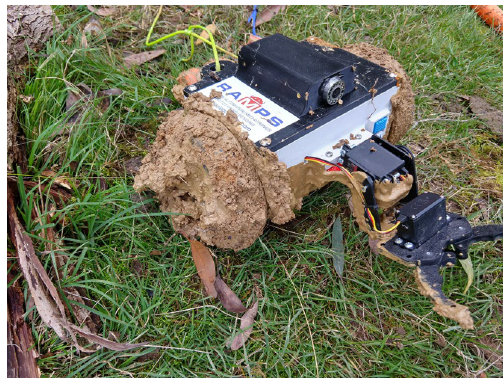
Fig. 5 An early WomBot prototype using omniwheels and two main drive wheels which were quickly encased in mud during Vic- torian field trials with a soil containing significant